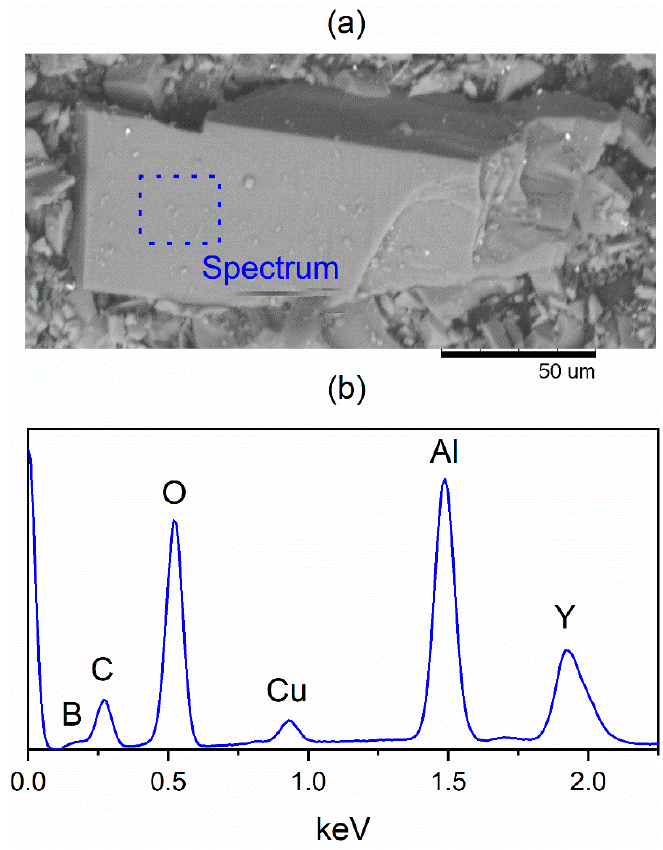
Figure 9. ( a ) Micrograph and ( b ) energy-dispersive X-Ray (EDX) spectrum of YAl 3 (BO 3 ) 4.